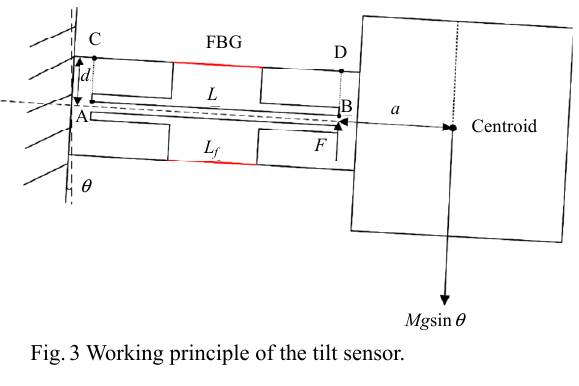
Fig. 3 Working principle of the tilt